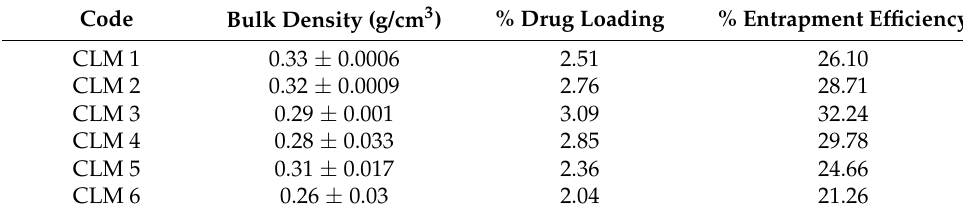
Table 3. Physical characteristics of alginate